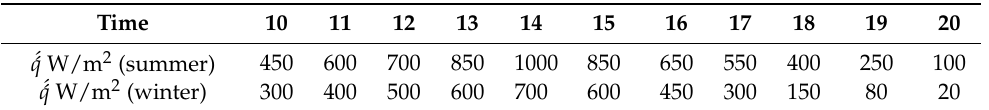
Table 3. The values of heat flux applied on the Tr-W at different hours of the day in winter and summer.